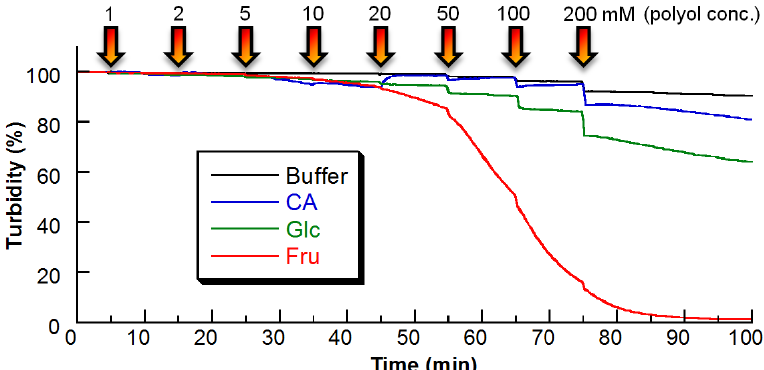
Figure 3. The turbidity change of the PBA–PEG/ γ -CyD PPRX depending on the sugar concentration (pH 7.4, 37